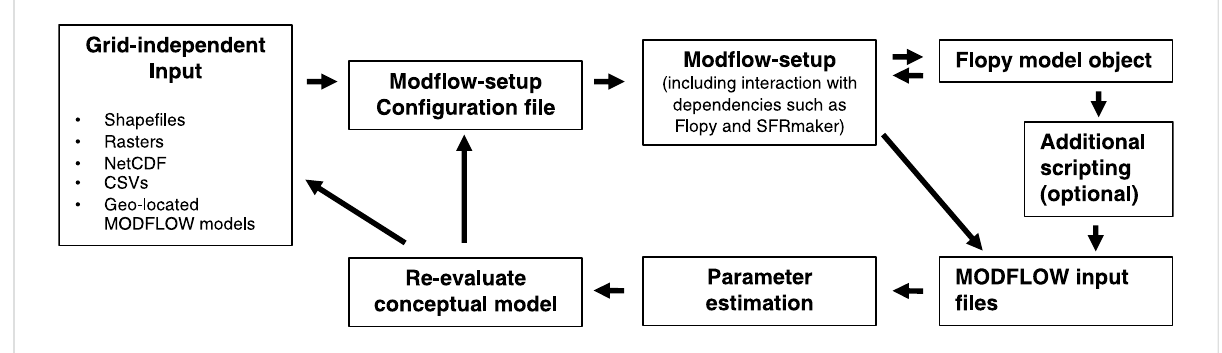
FIGURE 1 Mod fl ow-setup in the groundwater modeling work fl ow. Mod fl ow input can be written directly, or additional scripting can be performed with Flopy to customize the model. By automating the discretization of input data, Mod fl ow-setup allows the conceptual model and model structure to be more readily revised in response to parameter estimation or new